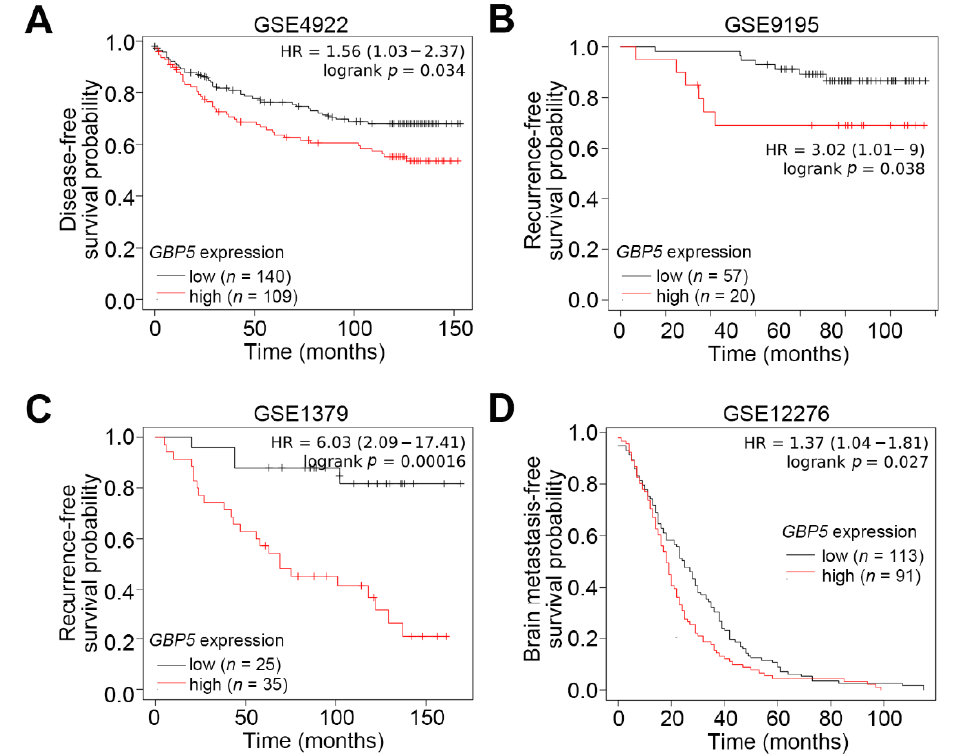
Figure 2. GBP5 is a poor prognostic marker in breast cancer patients. ( A – D ) Kaplan–Meier analyses for GBP5 transcripts using disease-free ( A ), recurrence-free ( B , C ) and brain metastasis-free ( D ) survival conditions under minimized log-rank p values against breast cancer patients derived from the GSE4922 ( A ), GSE9195 ( B ), GSE1379 ( C ) and GSE12276 ( D ) datasets.